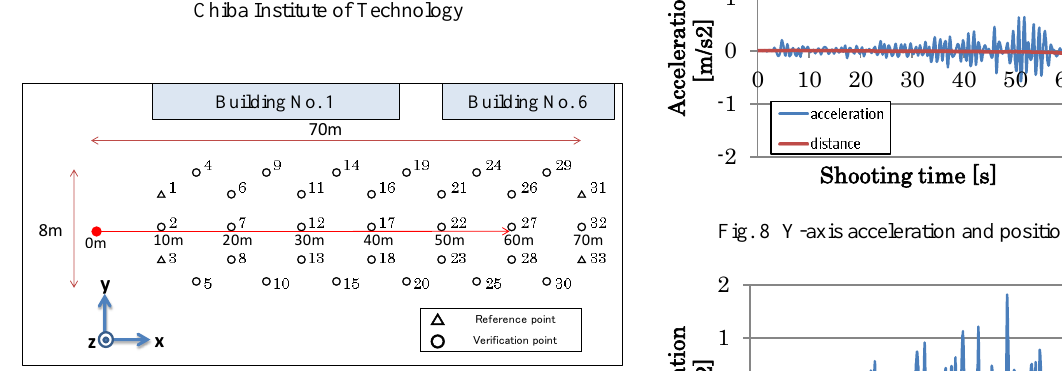
Fig. 5 West passage of No. 1 building of